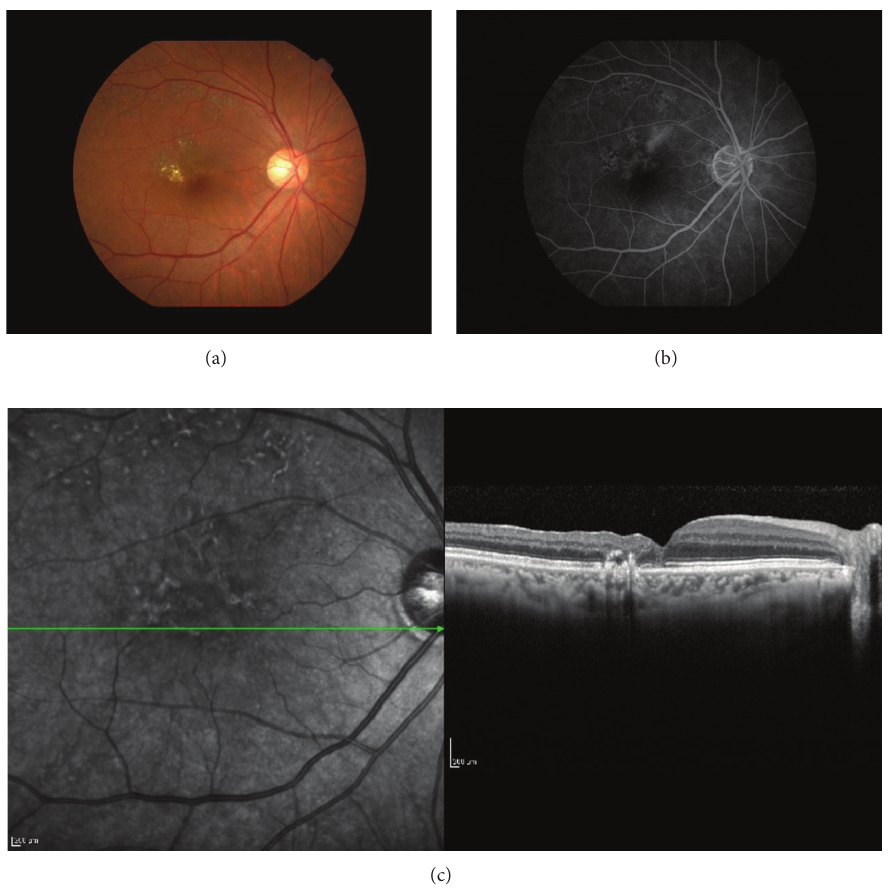
Figure 2: Findings of the right eye of Case 1 taken 3 months after surgery. The BCVA has improved to 20/25. (a) Fundus photograph showing localized area of scars from the laser photocoagulation temporal to the fovea. (b) Fluorescein angiogram showing the absence of fluorescein leakage in the late phase. (c) Optical coherence tomographic image showing an absence of cystoid macular edema and regained foveal